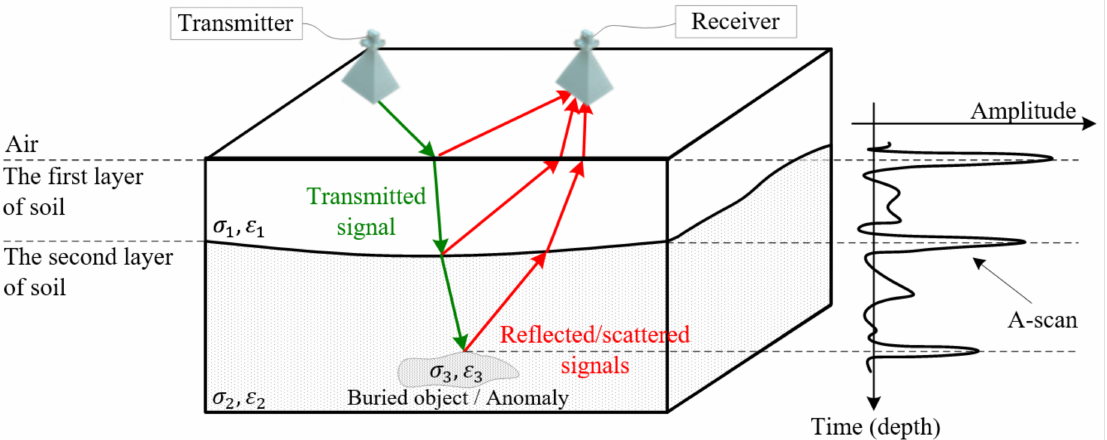
Figure 1. General idea of GPR operation.